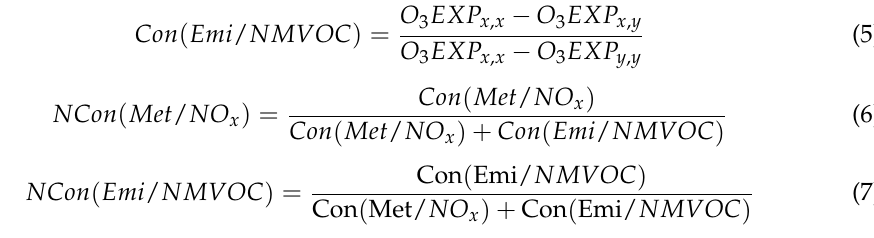
Table 2. BP network model used in the sensitivity contribution experiments.